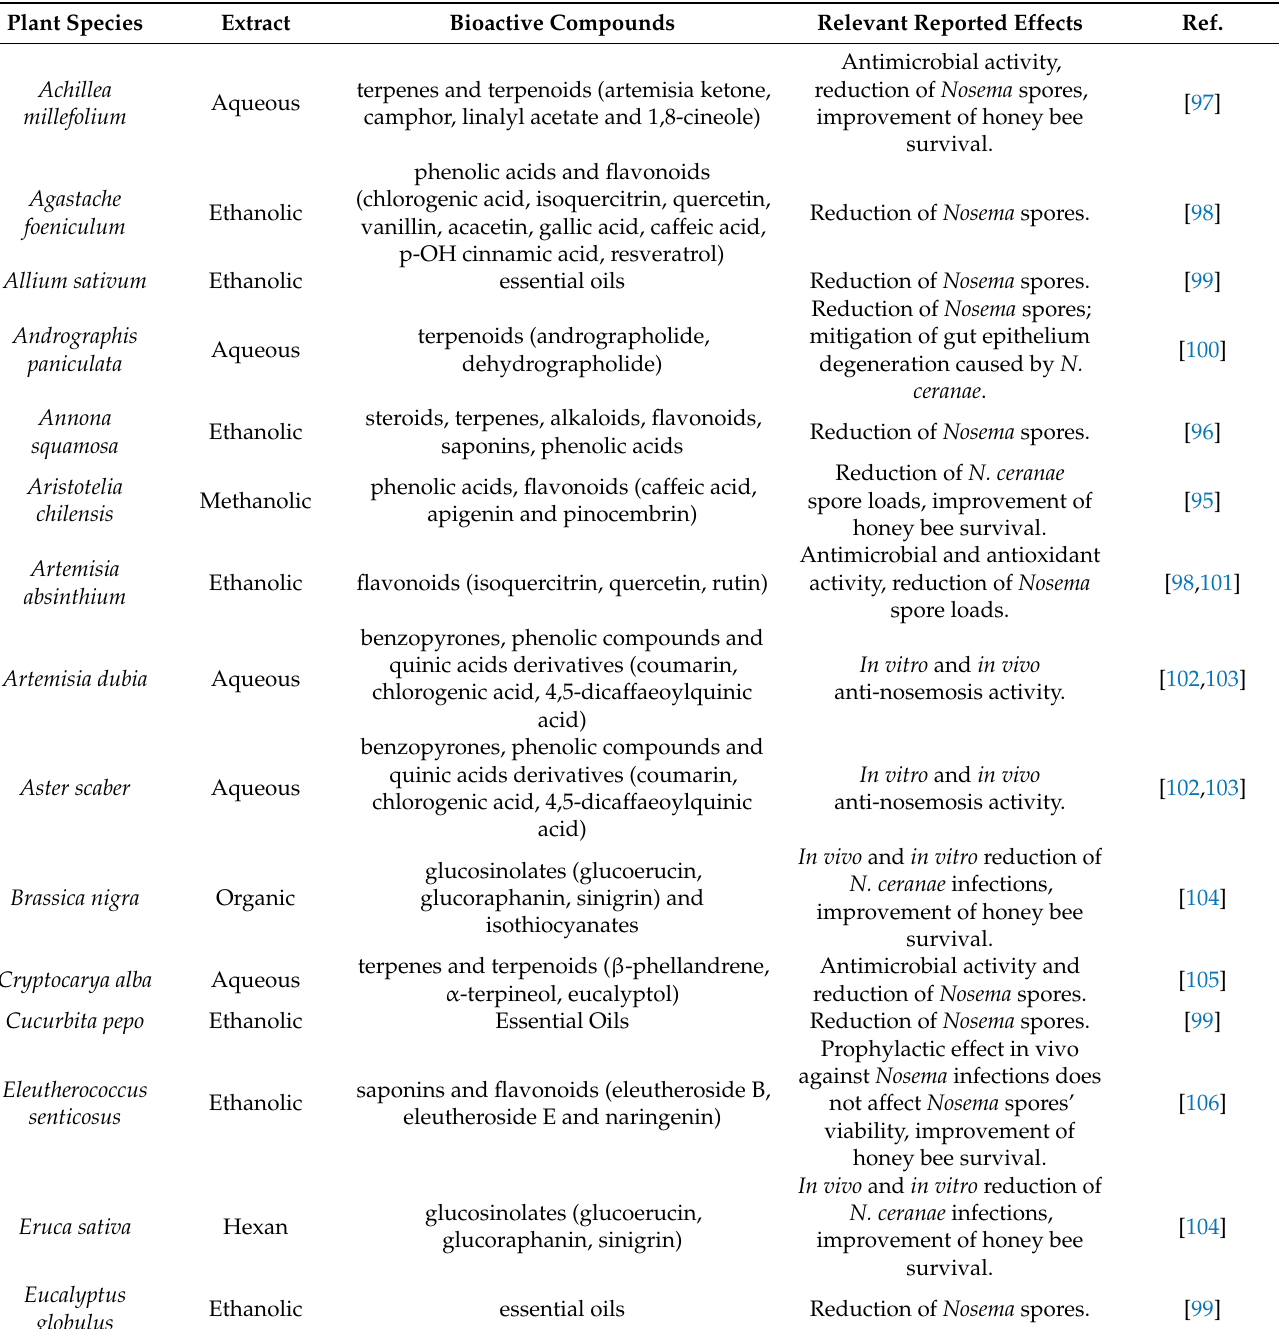
Table 1. List of plant species whose extracts, and relative bioactive compounds, are effective against